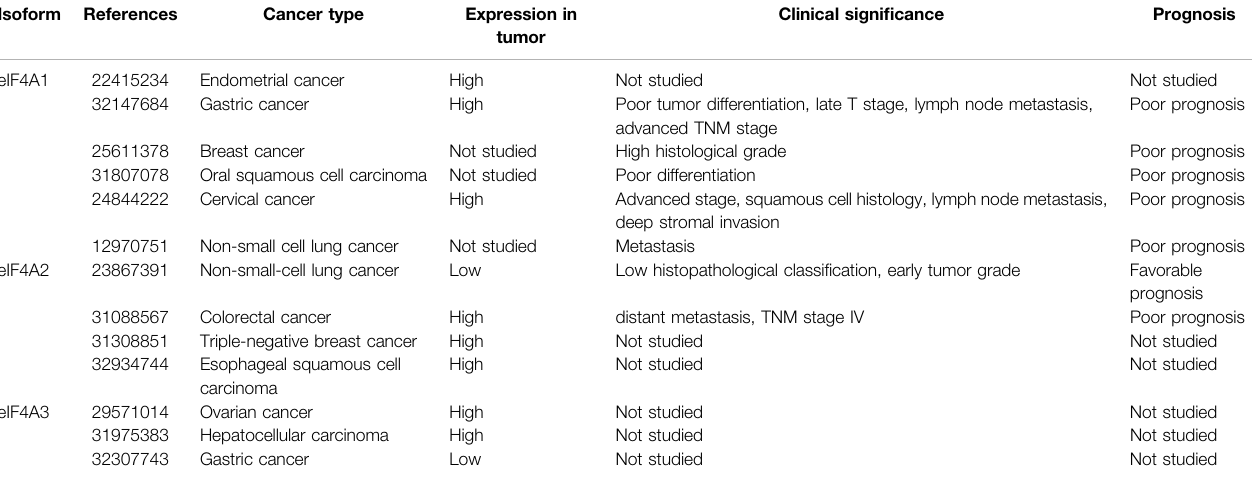
TABLE 1 | Expression patterns and clinical signi fi cance of the eIF4A family in human malignancies. Isoform